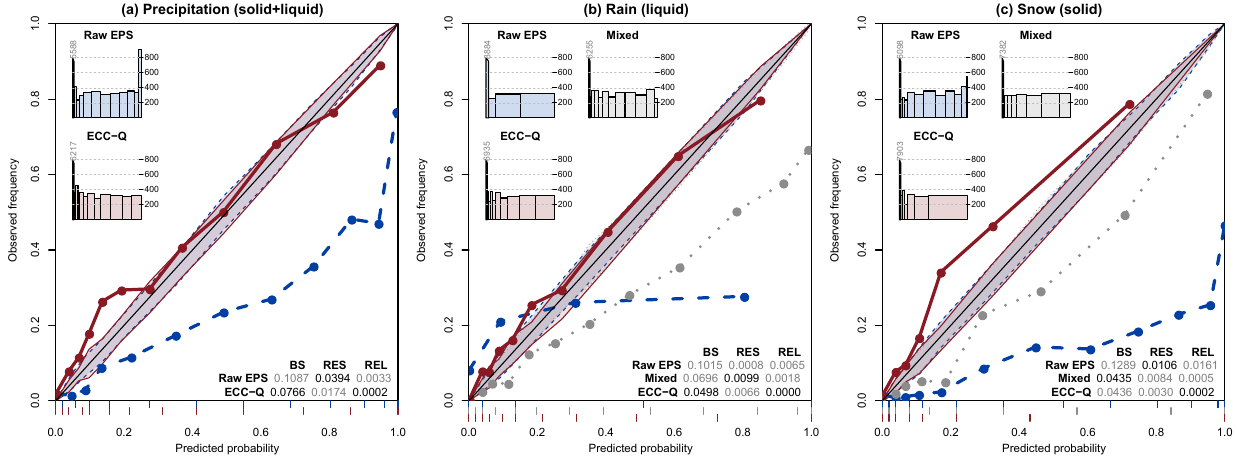
Figure 8. Reliability diagrams for hourly predictions of precipitation (snow ∨ rain; a ), snowfall (b) and rain (c) at Innsbruck Airport based on meteorological aerodrome reports (METARs) for the raw EPS (dashed) and the postprocessed forecasts (solid). Binning based on em- pirical quantiles to ensure a similar number of observations per bin (bins indicated along the x axis). The shaded area shows the 90% confidence interval. Histograms: counts of the number of observations in each bin in the reliability diagram. The analysis is based on ≈ 9700 observation–forecast pairs for each precipitation type. Mean Brier score (BS), as well as mean resolution (RES) and reliability (REL) from a BS decomposition (Murphy, 1973), are shown in the lower right